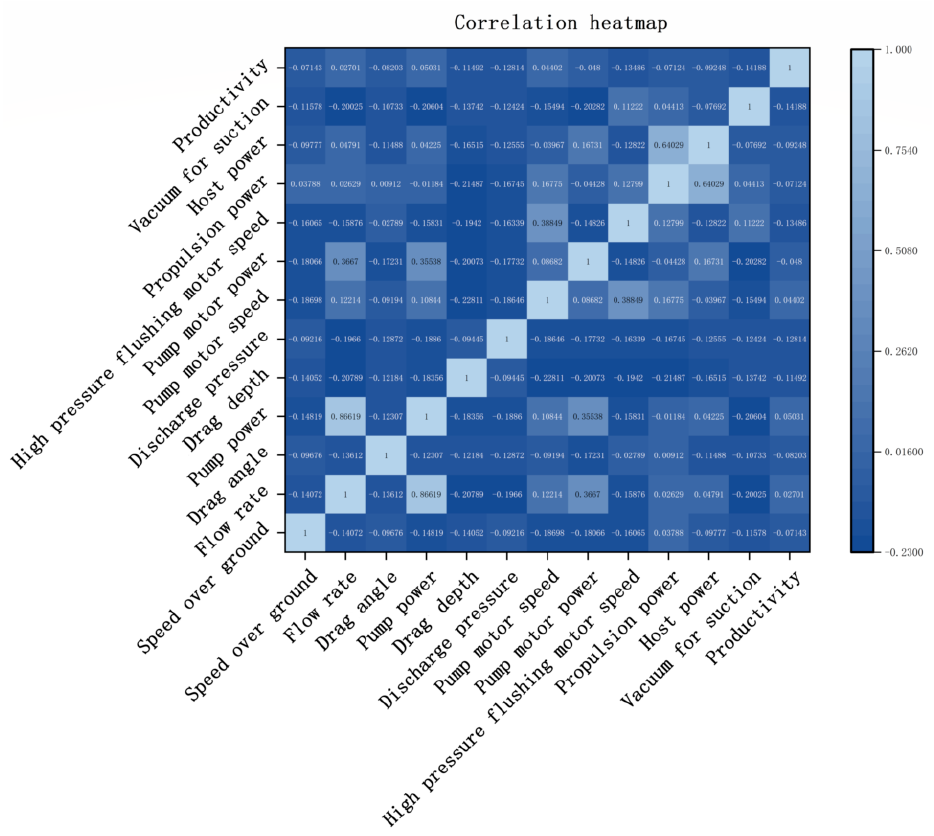
Figure 6. Correlation heatmap.